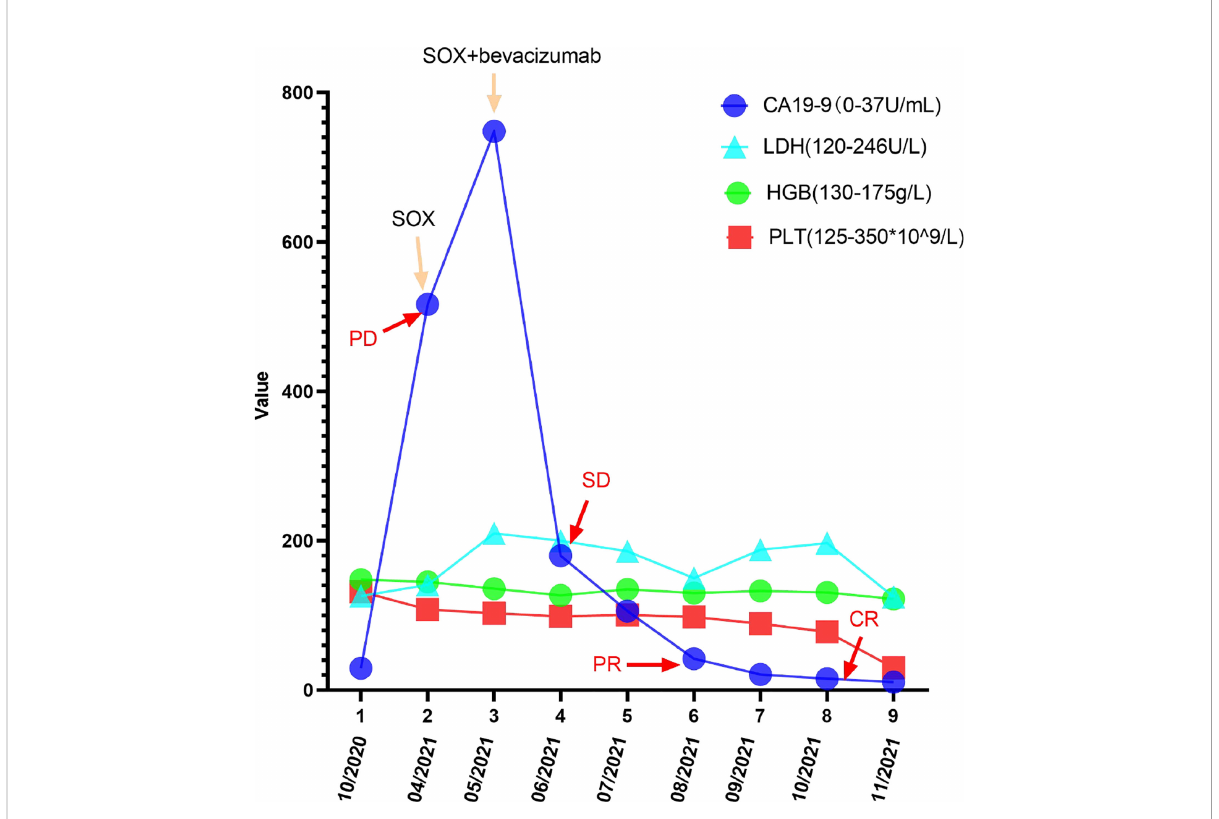
FIGURE 8 Changes in CA199, LDH, PLT, and HGB levels during the treatment and follow-up. The CA199 LDH, PLT, and HGB levels were measured in the patient ’ s blood at periodic intervals throughout the clinical course and annotated with date, therapeutic approach, and treatment ef fi